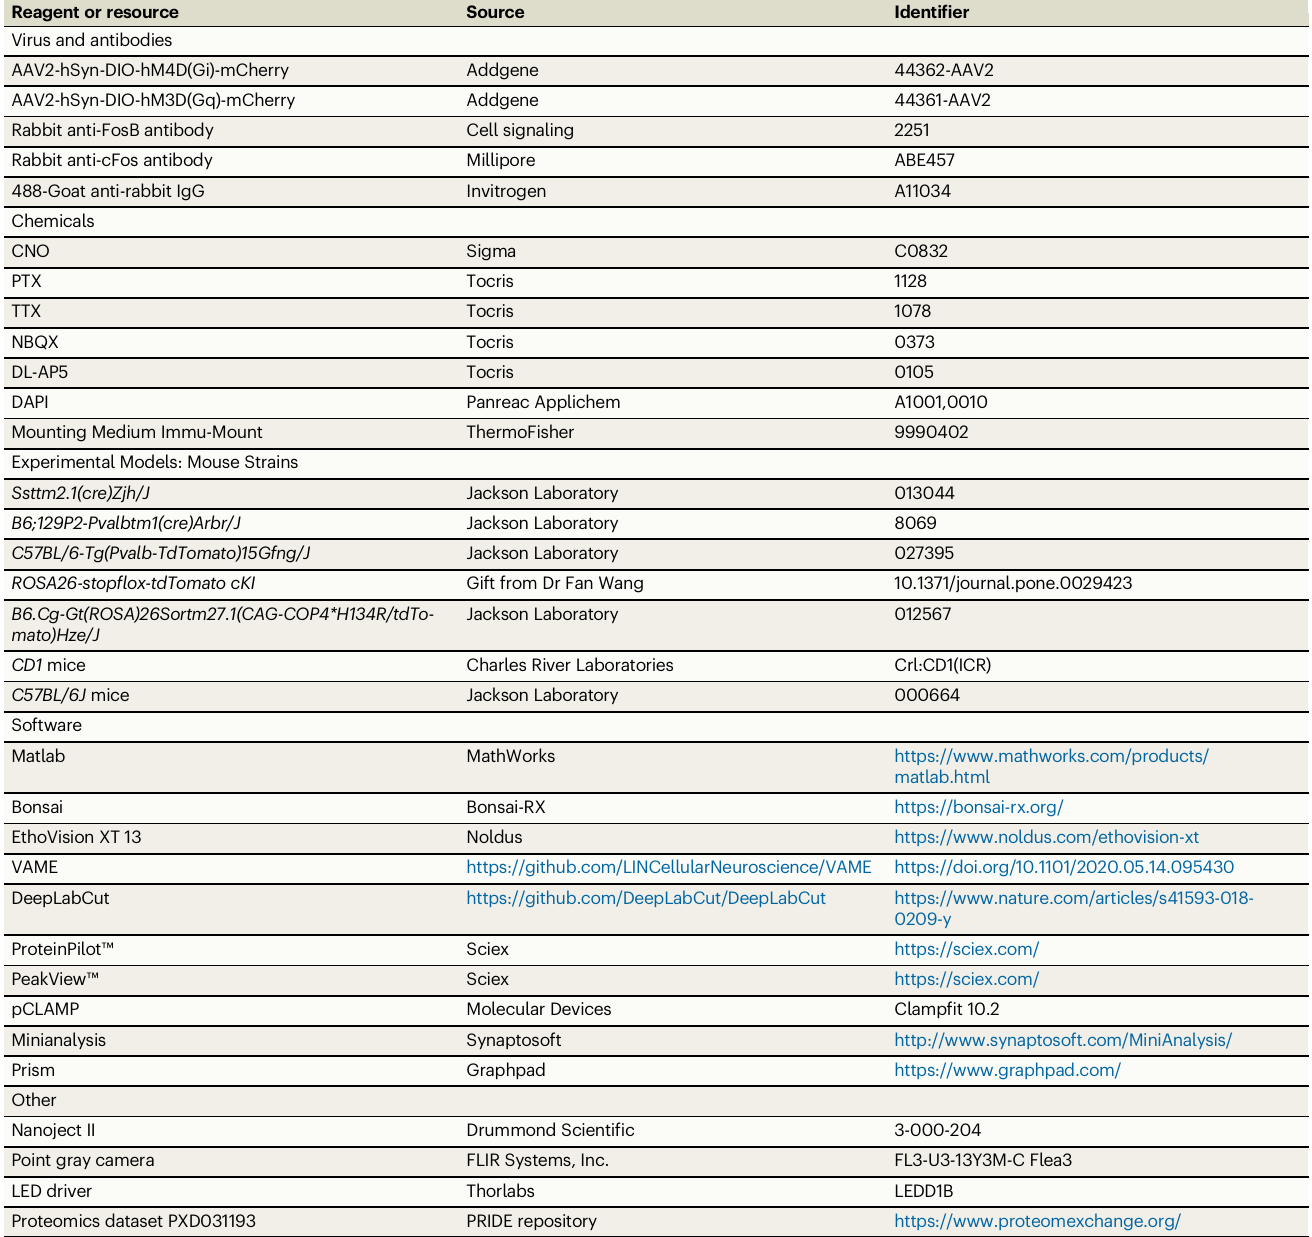
Table 1 | Materials and methods Reagent or